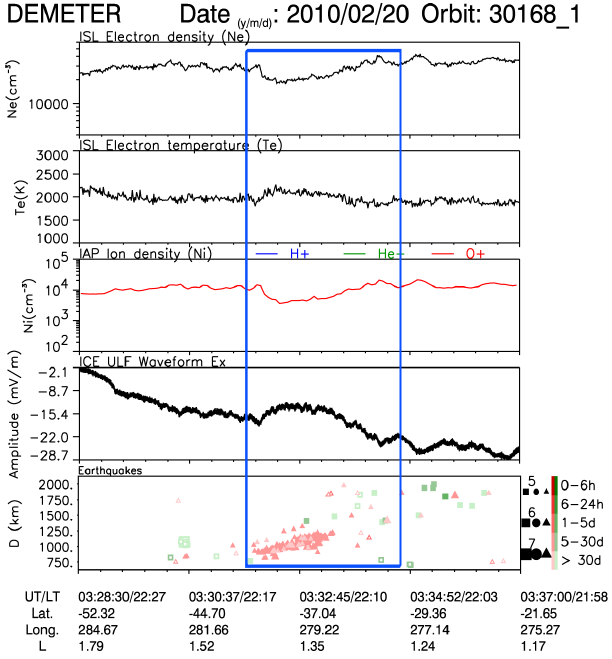
Figure 3. The observation of plasma parameters from DEMETER along orbit 30168 on 20 February 2010 before the Chile M8.8 earthquake on 27 February 2010 (first panel: N e ; second panel: T e ; third panel: the ion density of O + ; fourth panel: the electric field Ex; bottom panel: the earthquakes taking place within ± 30 days relative to the time of this orbit at a distance of 2000km from the orbit; green squares represent past earthquakes, red triangles mean future earthquakes and open squares are the epicenters at geomag- netic conjugate position).